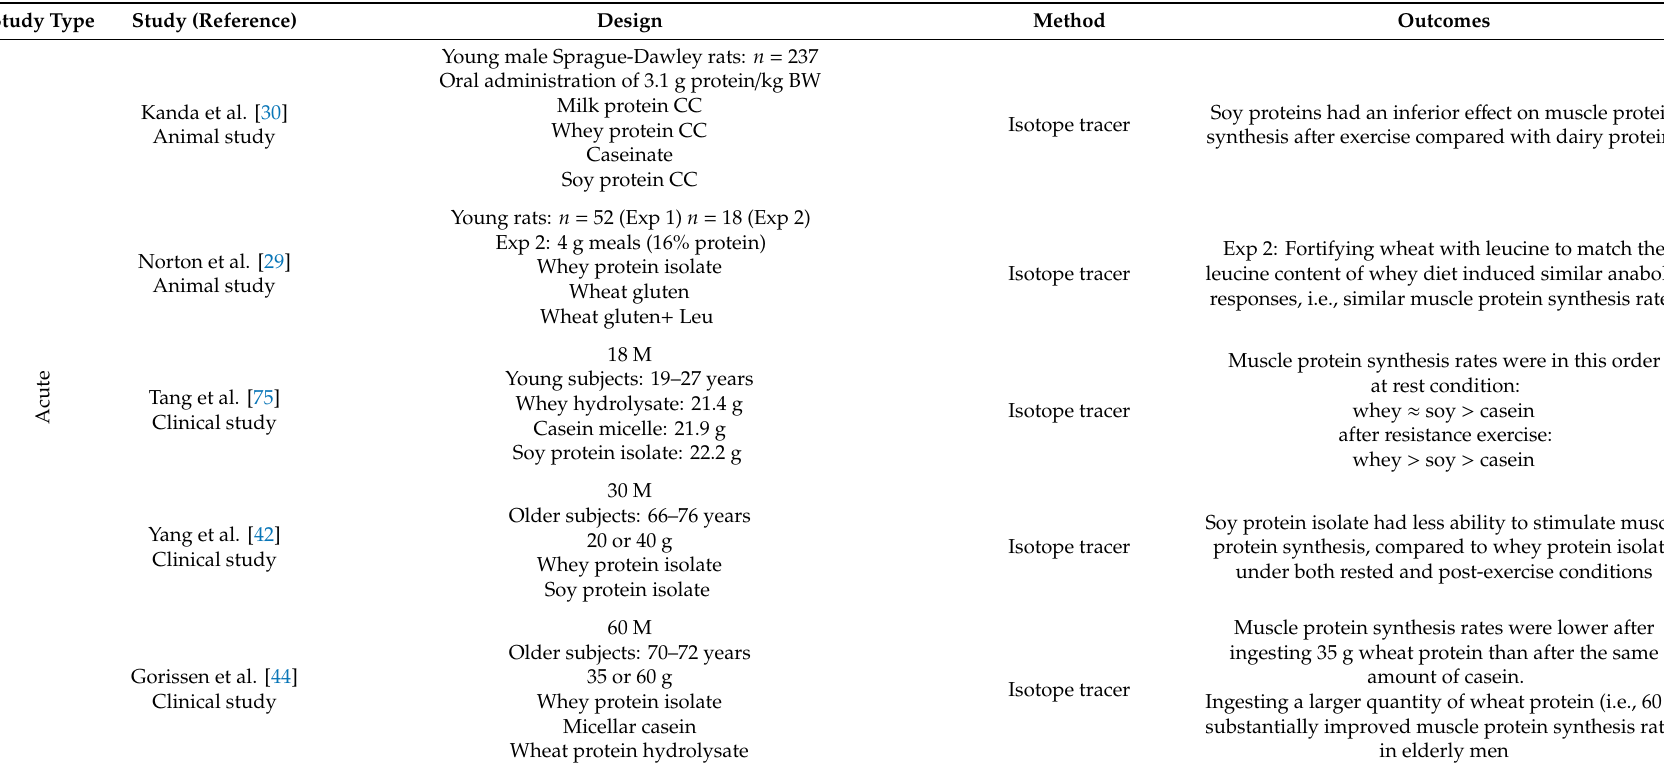
Table 3. Studies carried out in the last ten years, assessing the anabolic properties of plant-based protein